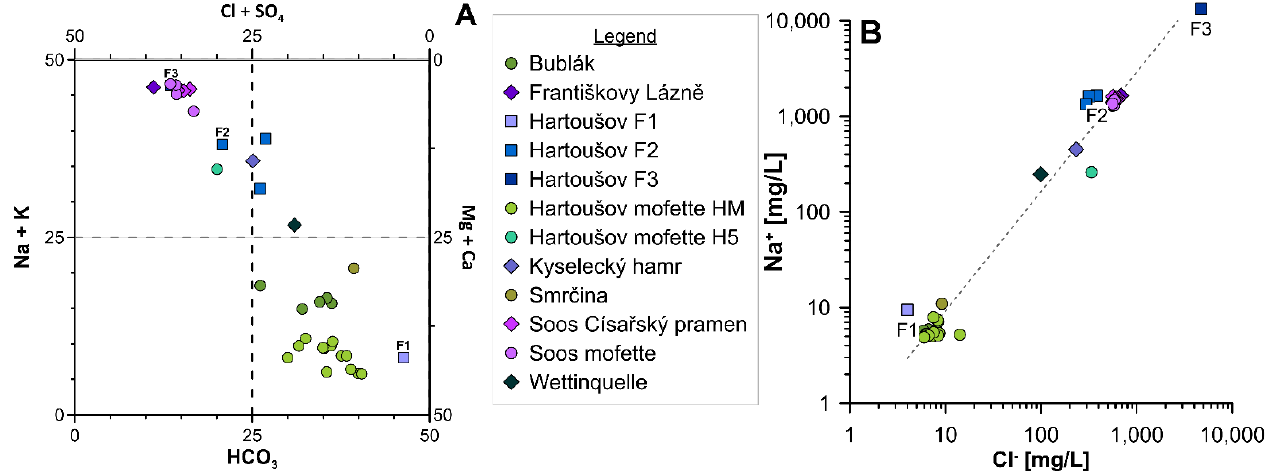
Figure 5. Chemical composition of Cheb basin fluids (circles—mofettes, diamonds—mineral springs, squares—wells). ( A ) Langelier–Ludwig diagram [32] showing element ratios in mmol(eq)%, ( B ) Na + vs. Cl − concentrations plot on a mixing line between the end-members F1 and F3.